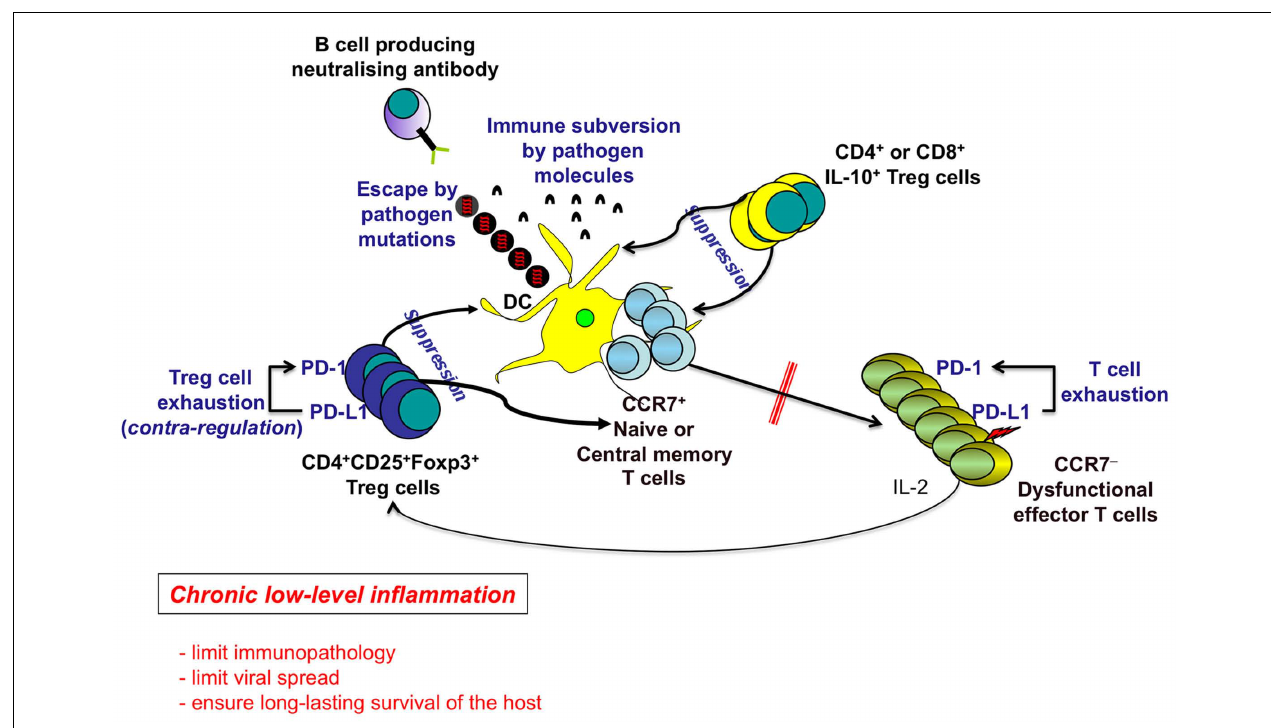
FIGURE 4 | Chronic low-level inflammation as an advantage for the long-term human survival. Several mechanisms induced by both persistent pathogens (e.g., escape by pathogen mutations, pathogen-related immune subversion) and the host [e.g., PD-1-dependentT cell exhaustion, RegulatoryT (T reg ) cells] contribute to the maintenance of chronic inflammatory diseases, by down-modulating DC functions,T and B cell priming, generation of memory cells, and ultimately differentiation of terminal effector cells.T reg cells can be represented by the following: (a) CD4 + CD25 + Foxp3 + T reg cells, which suppress via cell–cell contact, IL-2